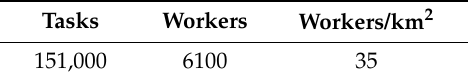
Table 1. Dataset characteristics.